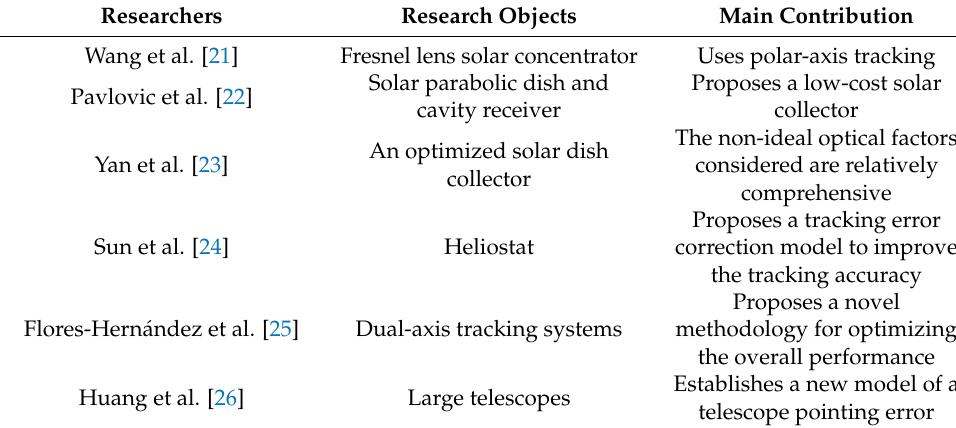
Table 1. Previous researchers’ related work (in